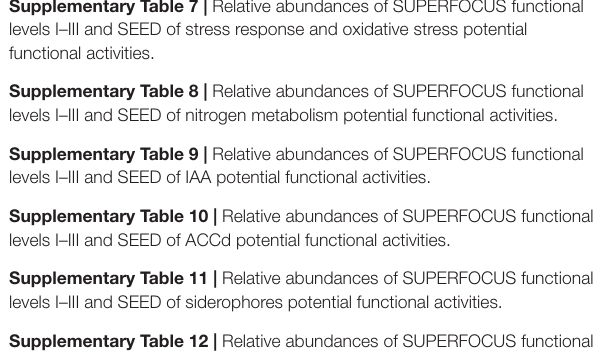
Supplementary Table 4 | Relative abundances of SUPERFOCUS functional level III. Supplementary Table 5 | Relative abundances of SUPERFOCUS at SEED function